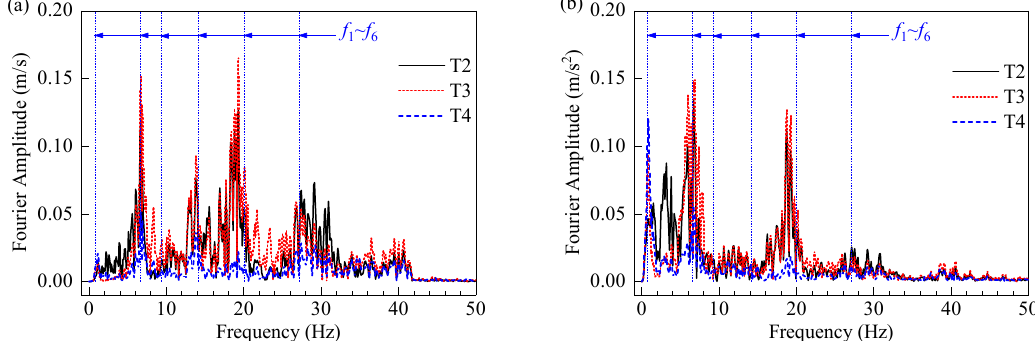
Figure 13. Accelerations Fourier amplitude of 3# tower ( a ) subjected to ScEL; ( b ) subjected to ScTCU.